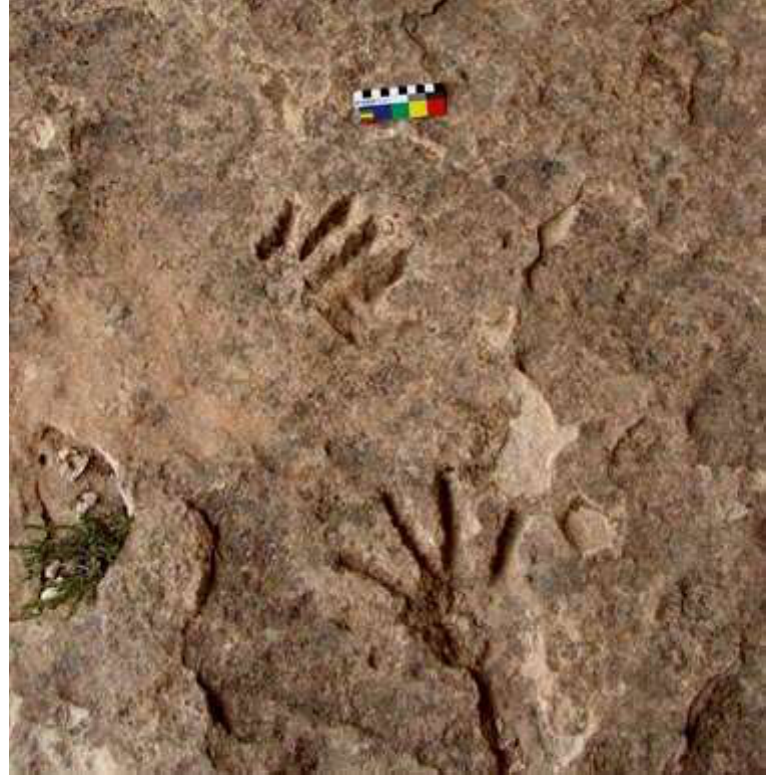
Figure 19. Rock shelter of Karaftou Cave heights; the hand petroglyphs on the horizontal surface of the shelter are created with deep carving.